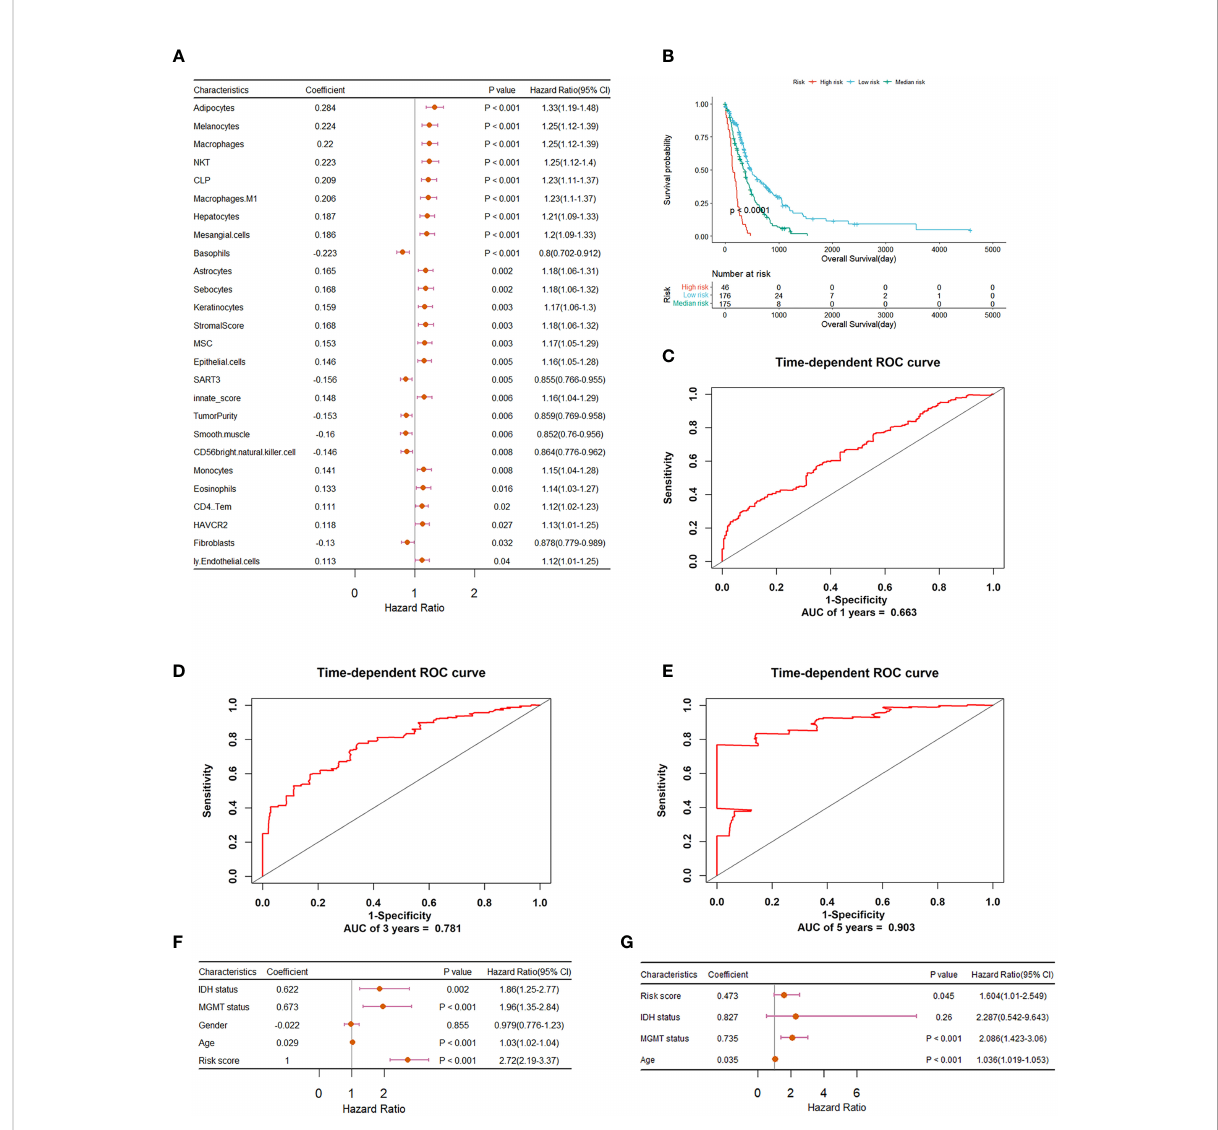
FIGURE 2 Construction and evaluation of the risk prognostic model based on immune features for GBM patients. (A) Forest plot summary of univariate Cox regression analysis of immune features signi fi cantly associated with overall survival. (B) Kaplan – Meier survival analysis of GBM patients that were divided into high-, medium-, and low-risk groups using a cutoff determined by X-tile. (C – E) ROC validation of the prognostic value of the predictive signature for predicting 1-, 3-, and 5-year survival of GBM patients, respectively. (F) Forest plot summary of the univariable analysis of IDH status, MGMT status, gender, age, and risk score. (G) Forest plot summary of the multivariable analysis of risk score, IDH status, MGMT status, and age. Here, the wildtype and mutant status of IDH and the unmethylated and methylated status of MGMT promoter were both converted to 1 and 0